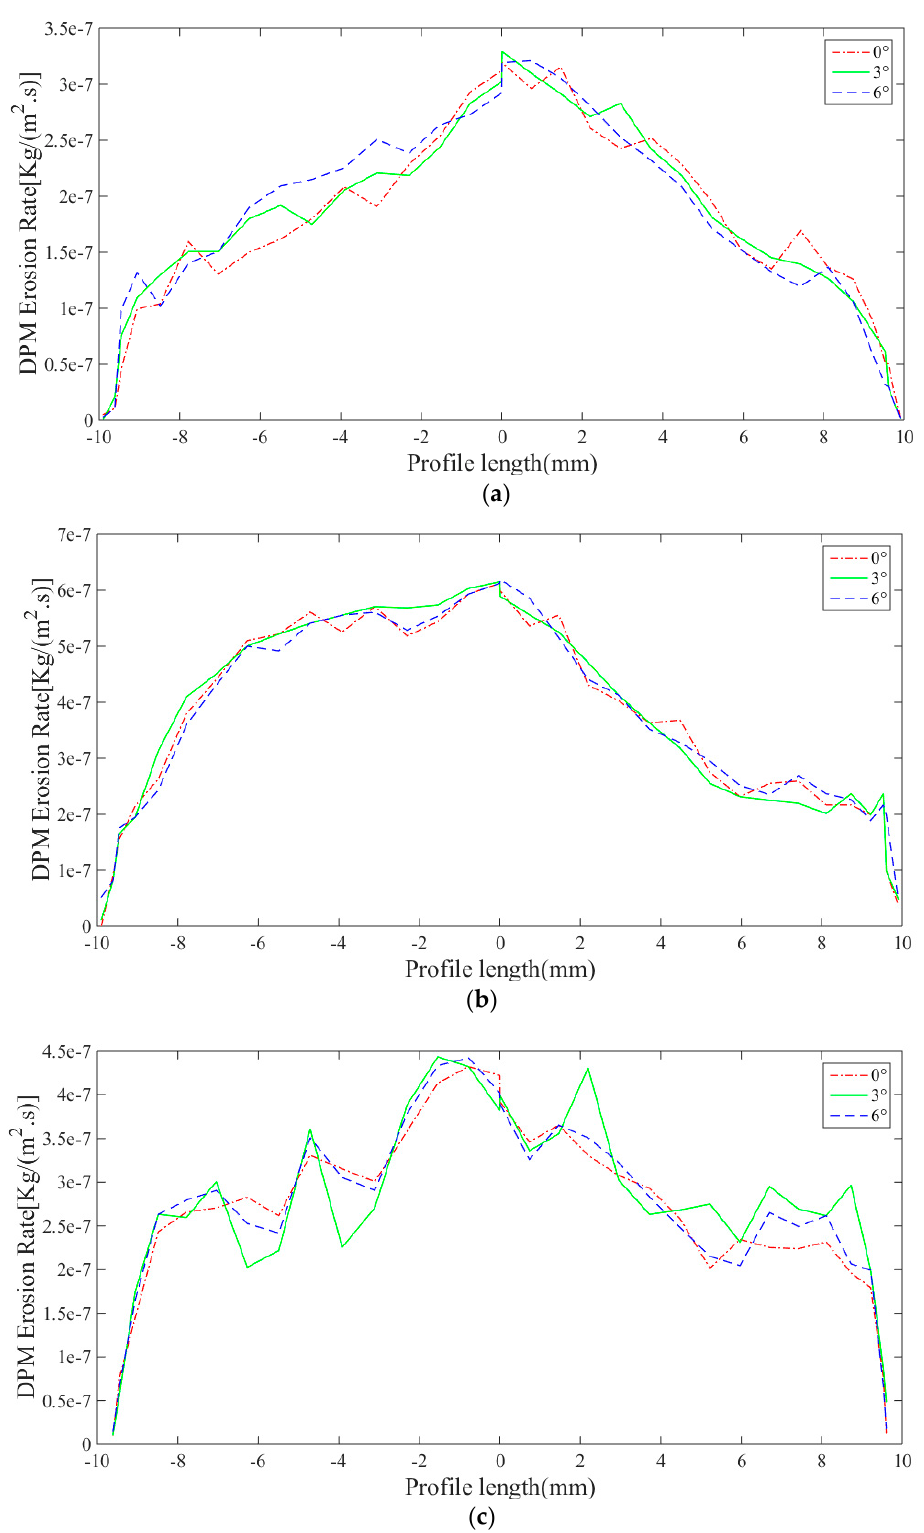
Figure 12. Erosion rate curves of the three materials at different angles of attack at impact speed of 220 m/s: ( a ) Ti-4Al-1.5Mn; ( b ) Mg-Li9-A3-Zn3; ( c ) Al7075-T6. Table 7. Average erosion rates of the three material at different angles of attack.